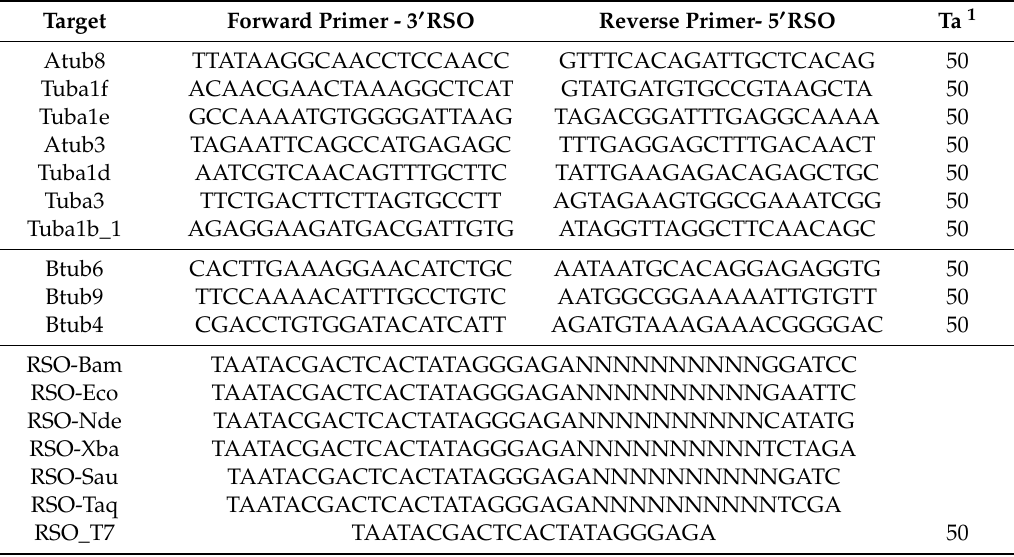
Table 8. Oligonucleotides used as primers for the